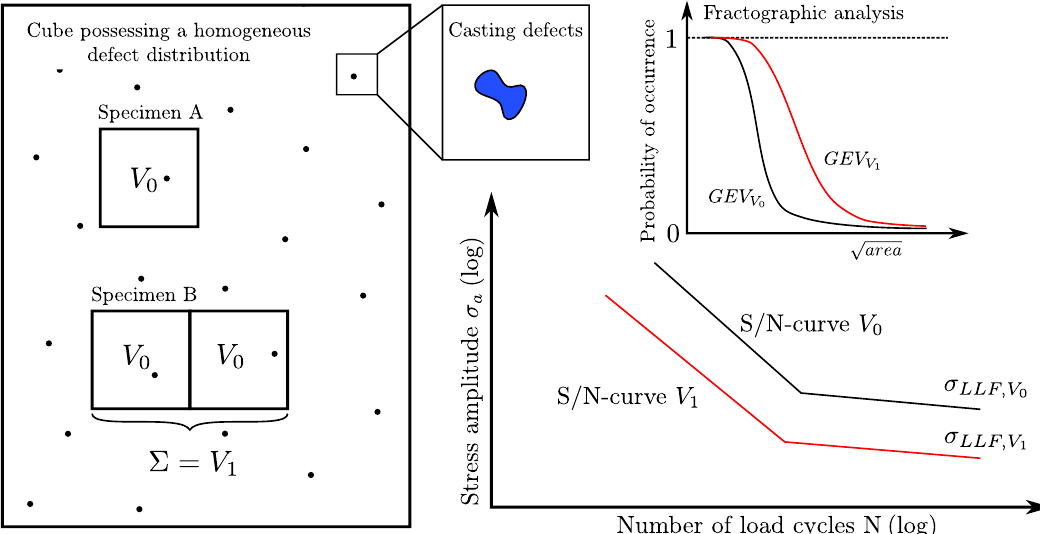
Figure A1. Schematic representation of the specimens manufactured from a cube possessing a homogeneous defect distribution and sketch of expected fatigue strength